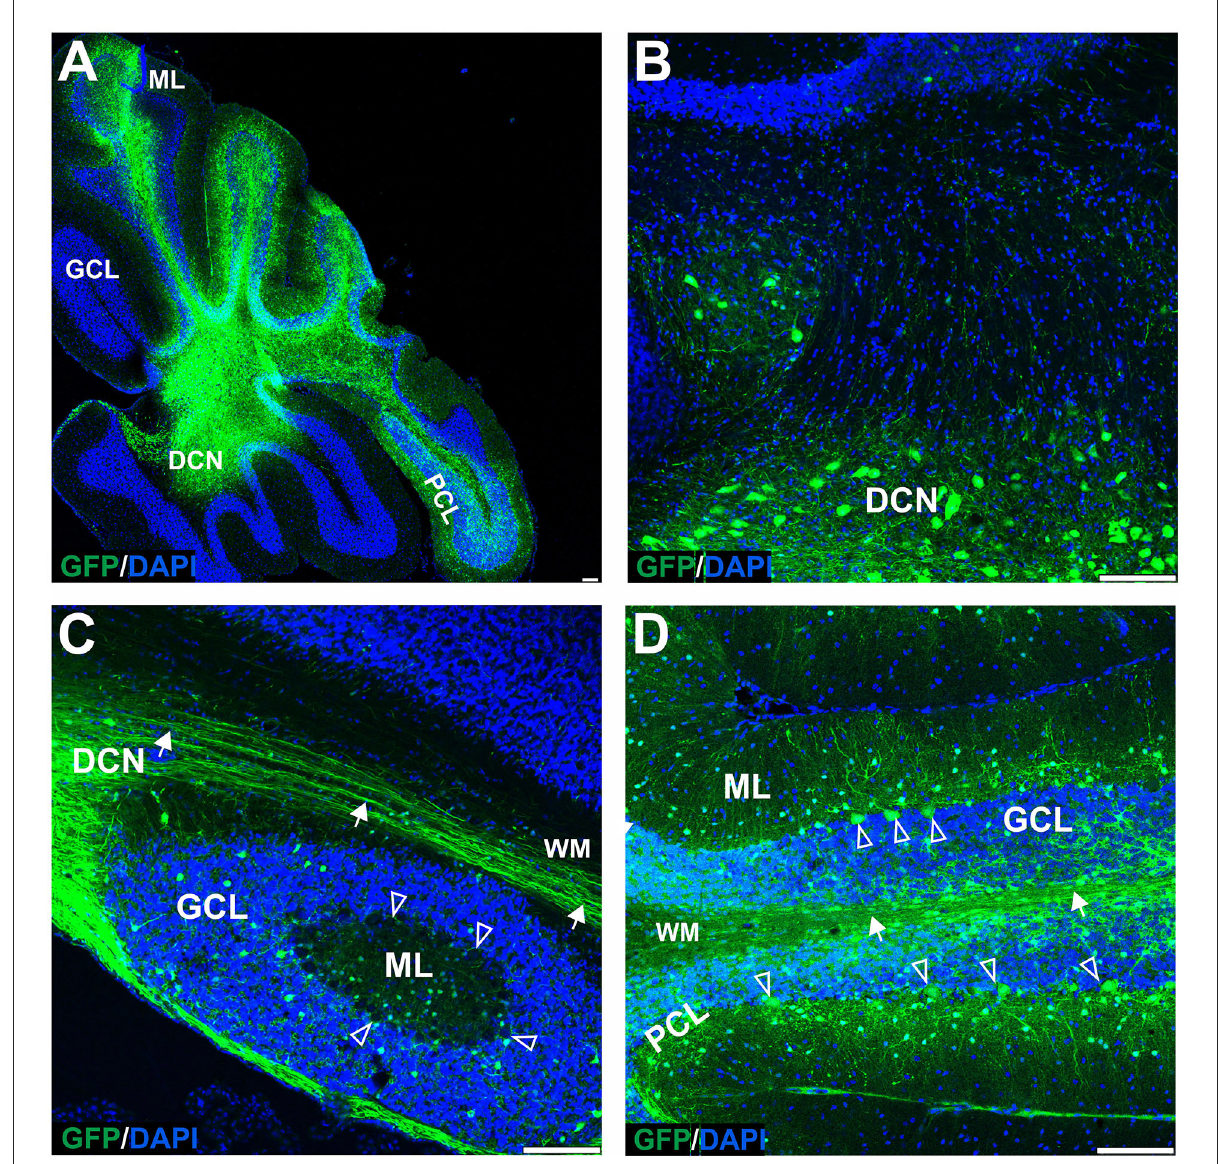
FIGURE4 The transduction of the mouse cerebellum after injection of the eGFP-encoding AAVrh10 vector into deep cerebellar nuclei. Green eGFP + signal was observed in deep cerebellar nuclei (A,B) and white matter (A–D) , in DCN neurons (B) , Purkinje cells, and cells of the molecular and granule cell layers (D) . Despite the selection of relatively prolonged time of observation (10 weeks post-injection) and the occurrence of intensive staining of the white matter fibers (likely Purkinje cell axons), the eGFP + Purkinje cell bodies and dendrites did not occur very frequently. Unfilled arrowheads: Purkinje cell bodies. Arrows: eGFP expression in PC axons. DCN, deep cerebellar nuclei; GCL, granule cell layer; ML, molecular layer; PCL, Purkinje cell layer; WM, white matter. Sagittal sections. Bars: 100 µ m in the lower right corner of images. Purkinje cell transduction efficiency at DCN injection with AAVrh10: 13% ( N = 3 animals, see Figure 8).